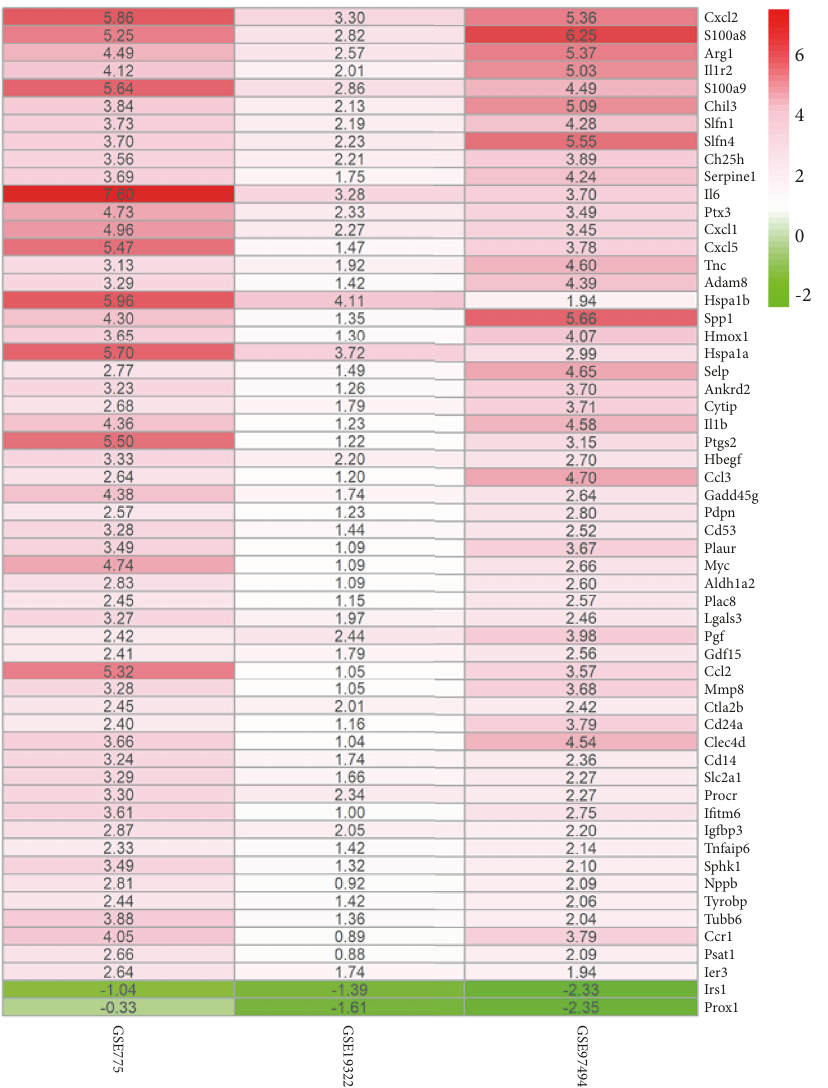
Figure 3: The heatmap of differentially expressed genes. Notes: each column and row represents one dataset and one gene, respectively. Red and green represent logFC > 0 and logFC < 0, respectively. The logFC values are shown in each rectangle. The gradual color ranged from green to red represents the changing process from downregulation to upregulation. Abbreviation: FC, fold